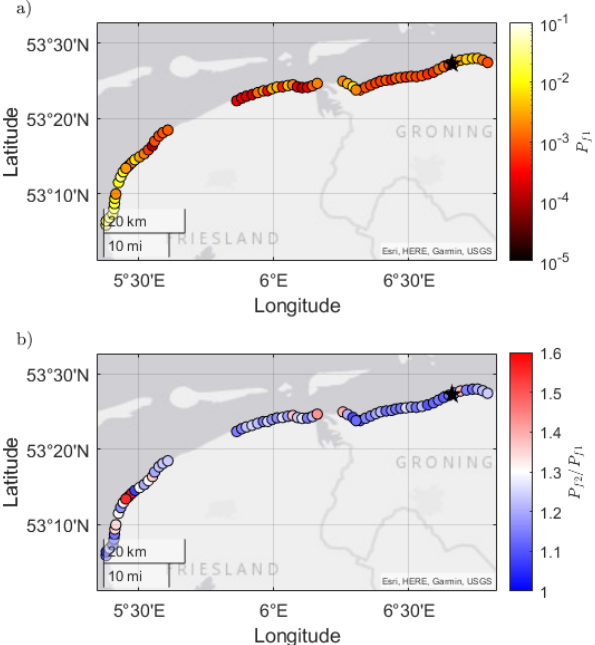
Figure 11. Spatial variation in the probability of dike failure by wave overtopping for (a) Scenario 1 of SS ( P f nario 2 of SS + IG relative to Scenario 1 ( P f wider Dutch Wadden Sea area for dikes with identical crest heights ( z c = 6m + NAP) and dike slopes (cot (α) = 7).